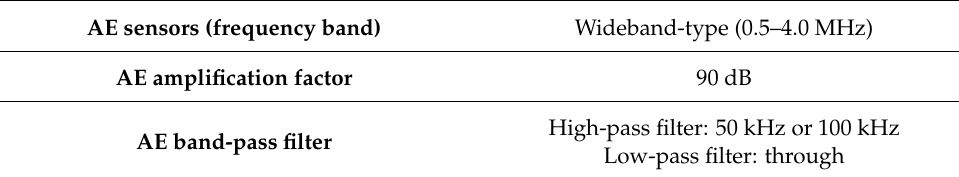
Figure 2. Schematic diagram of the experimental setup and the measurement system. Table 1. Summary of the AE measurement